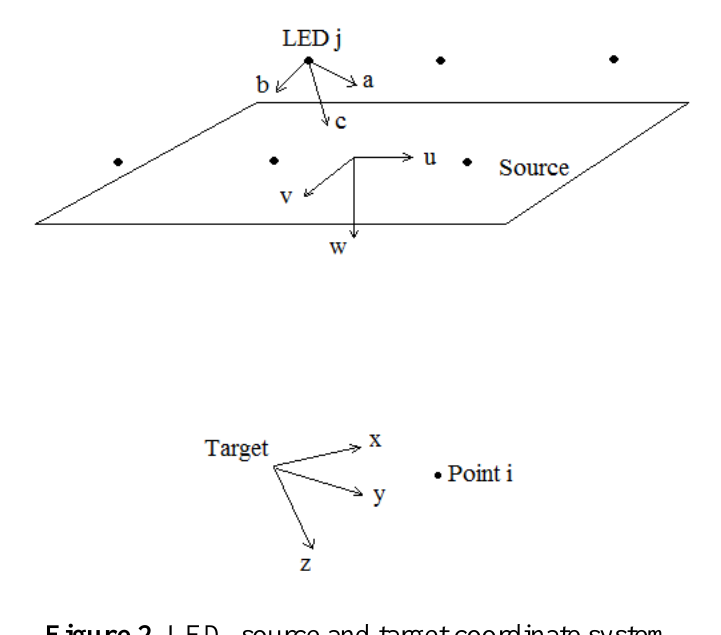
Figure 2. LED, source and target coordinate